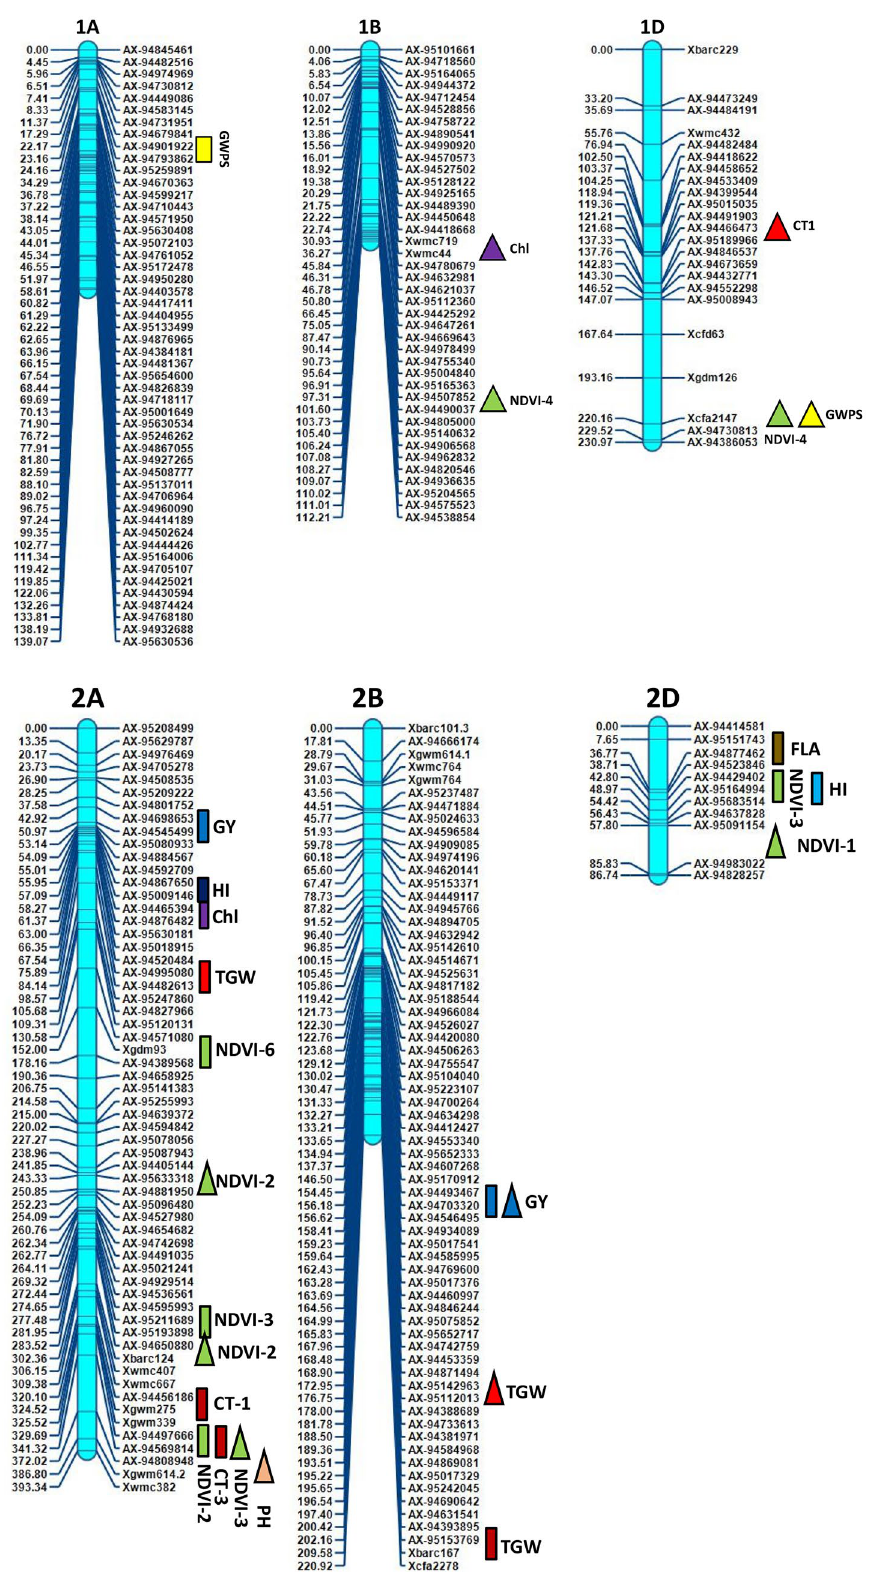
Figure 2. Genetic map of chromosomes showing QTL for physiological and yield component traits in the HD2733/2*C306 BILs population. Traits are projected as solid bars with different colours for which the legend is given at the end of figure. Rectangle locus represents main effect QTLs. Triangle locus represent epistatic effect QTLs. TGW, thousand grain weight, PH, plant height, GWPS, grain weight per spike, FLA, flag leaf area, CL, coleoptile length, AL, awn length, NDVI, normalized difference vegetative index, Chl, chlorophyll content, CT, canopy temperature, biomass, RWC, relate water content, DH, days to heading, HI, harvest index, GY, grain yield. IciMapping 4.1 software; http://www.isbre eding .net/softw are/defau lt.aspx?type=detai l&id=20 META-R, version 6.0: https ://data.cimmy t.org/datas et.xhtml ?persi stent Id=hdl:11529 /10201